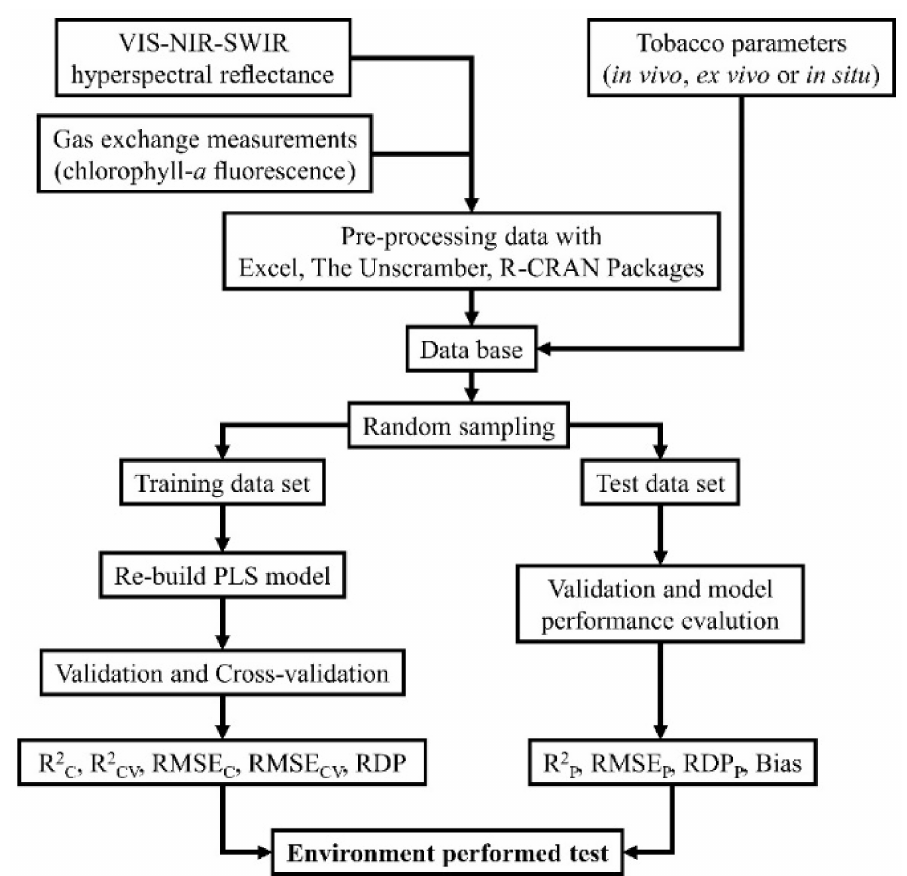
Figure 6. Flowchart of the methodology used in the PLSR analysis. Abbreviations—see Table 1 or abbreviation